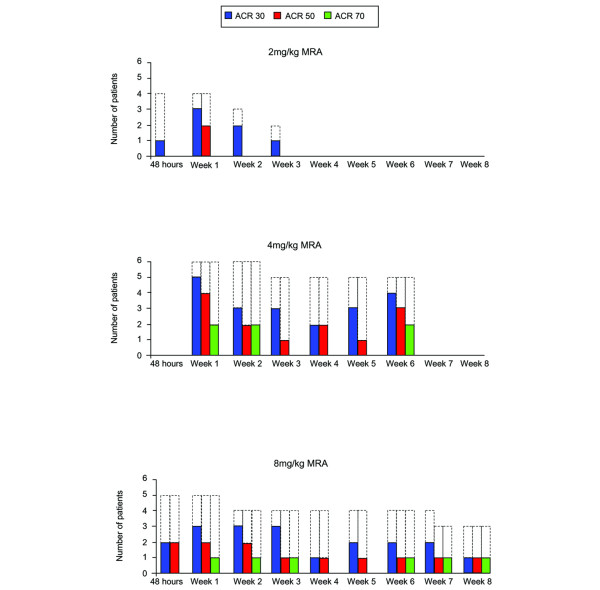
Cumulative number of patients improving from baseline in juvenile idiopathic arthritis core outcome variables (dotted lines show non-improvers); ACR, American College of Rheumatology.